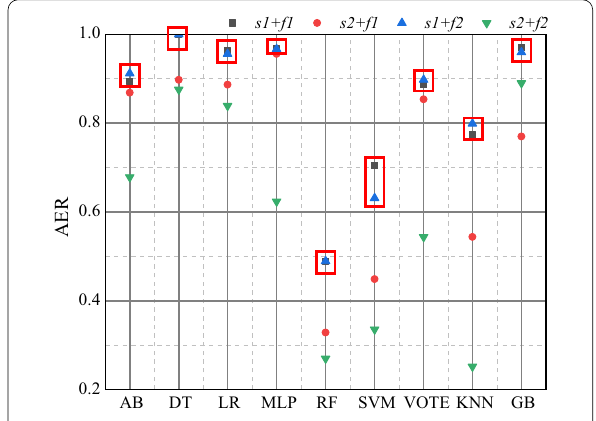
Fig. 7 The AER of different combination